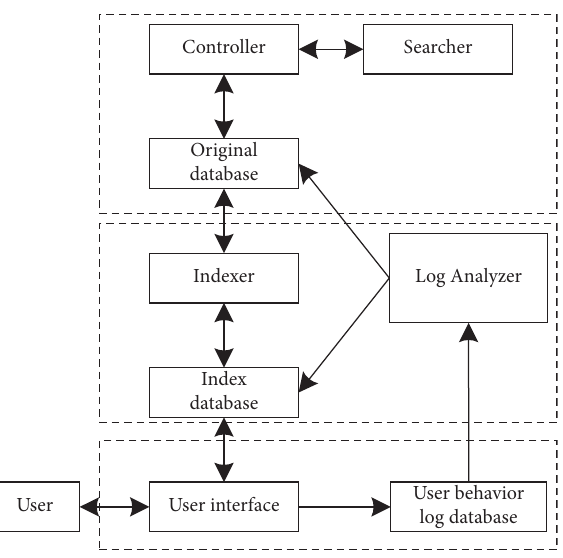
Figure 1: Architecture of digital service